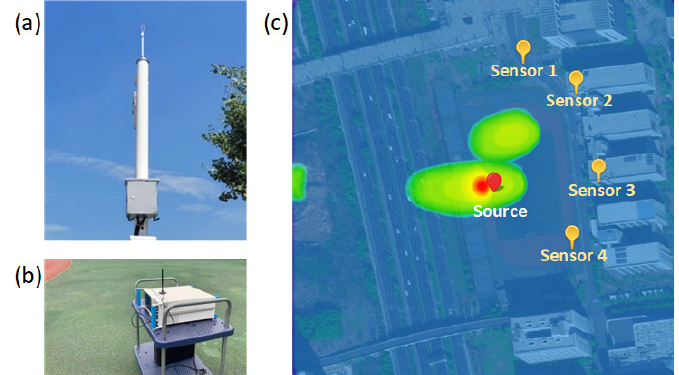
Figure 8. The real-world positioning scenario. ( a ) Physical drawing of a sensor. ( b ) Physical drawing of the radiation source. ( c ) Heatmap of the positioning result by the proposed method.